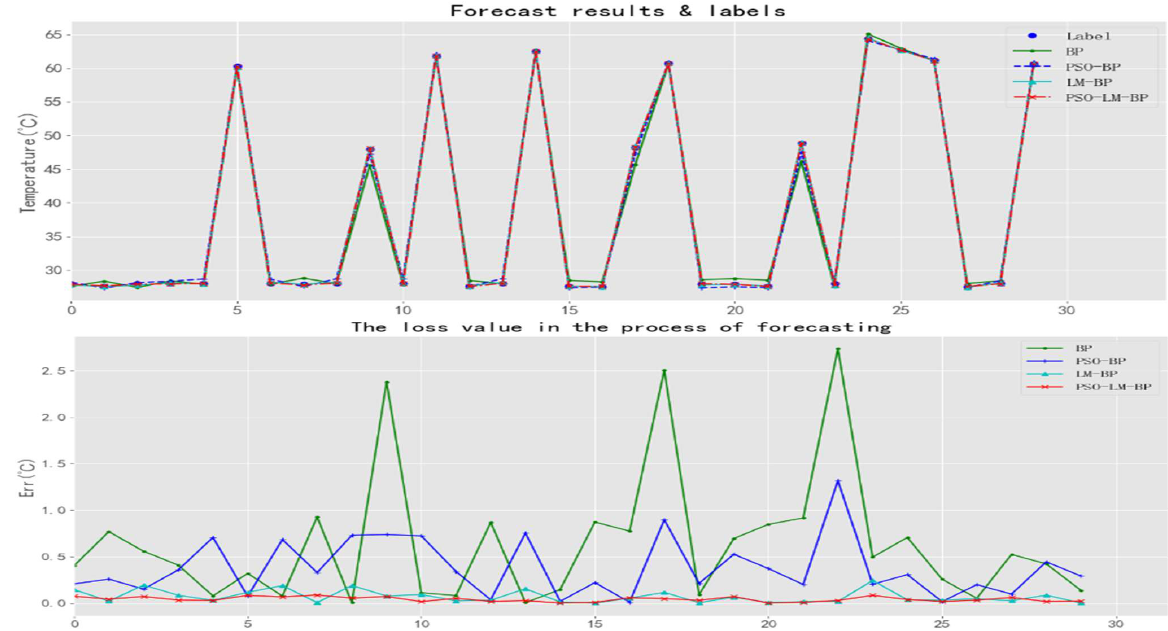
Figure 9. Up: Temperature prediction results of four kinds of network prediction processes; Down: Loss values of four kinds of network prediction processes.